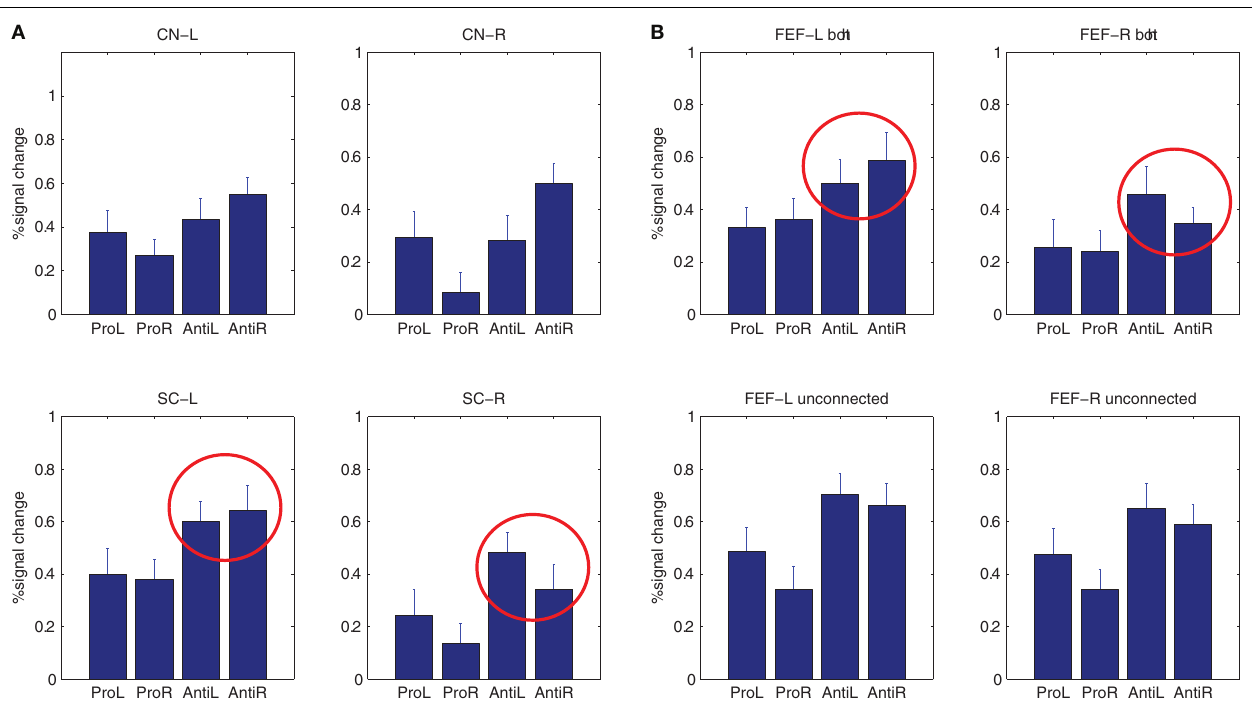
saccade direction is highlighted with red circles. Error bars denote standard error. (B) Same response amplitudes for FEF zones connected to both the CN and SC and for FEF zones connected to neither SC nor